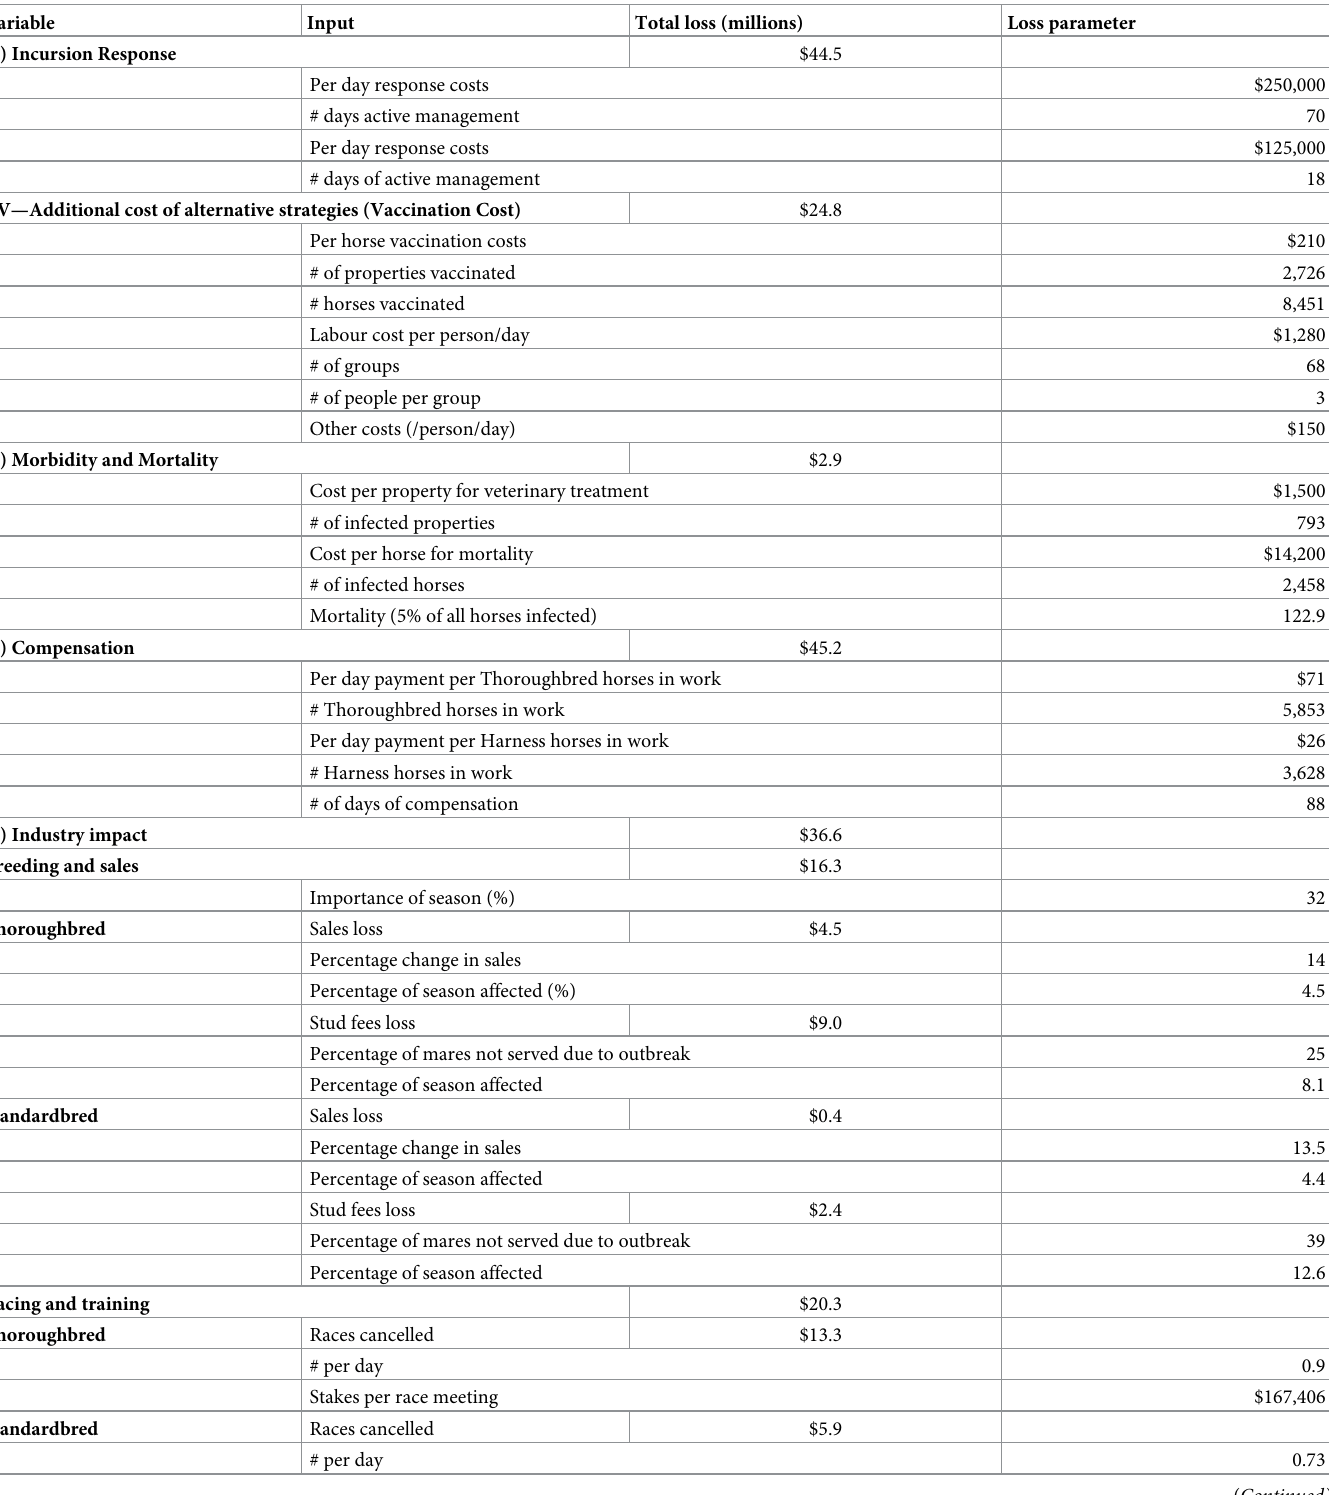
Table 3. An example of the input values and losses associated with the eradication of equine influenza in New Zealand under the suppressive vaccination strategy in the breeding season (August to October). The duration of the outbreak, number of infected and vaccinated properties determined through simulation